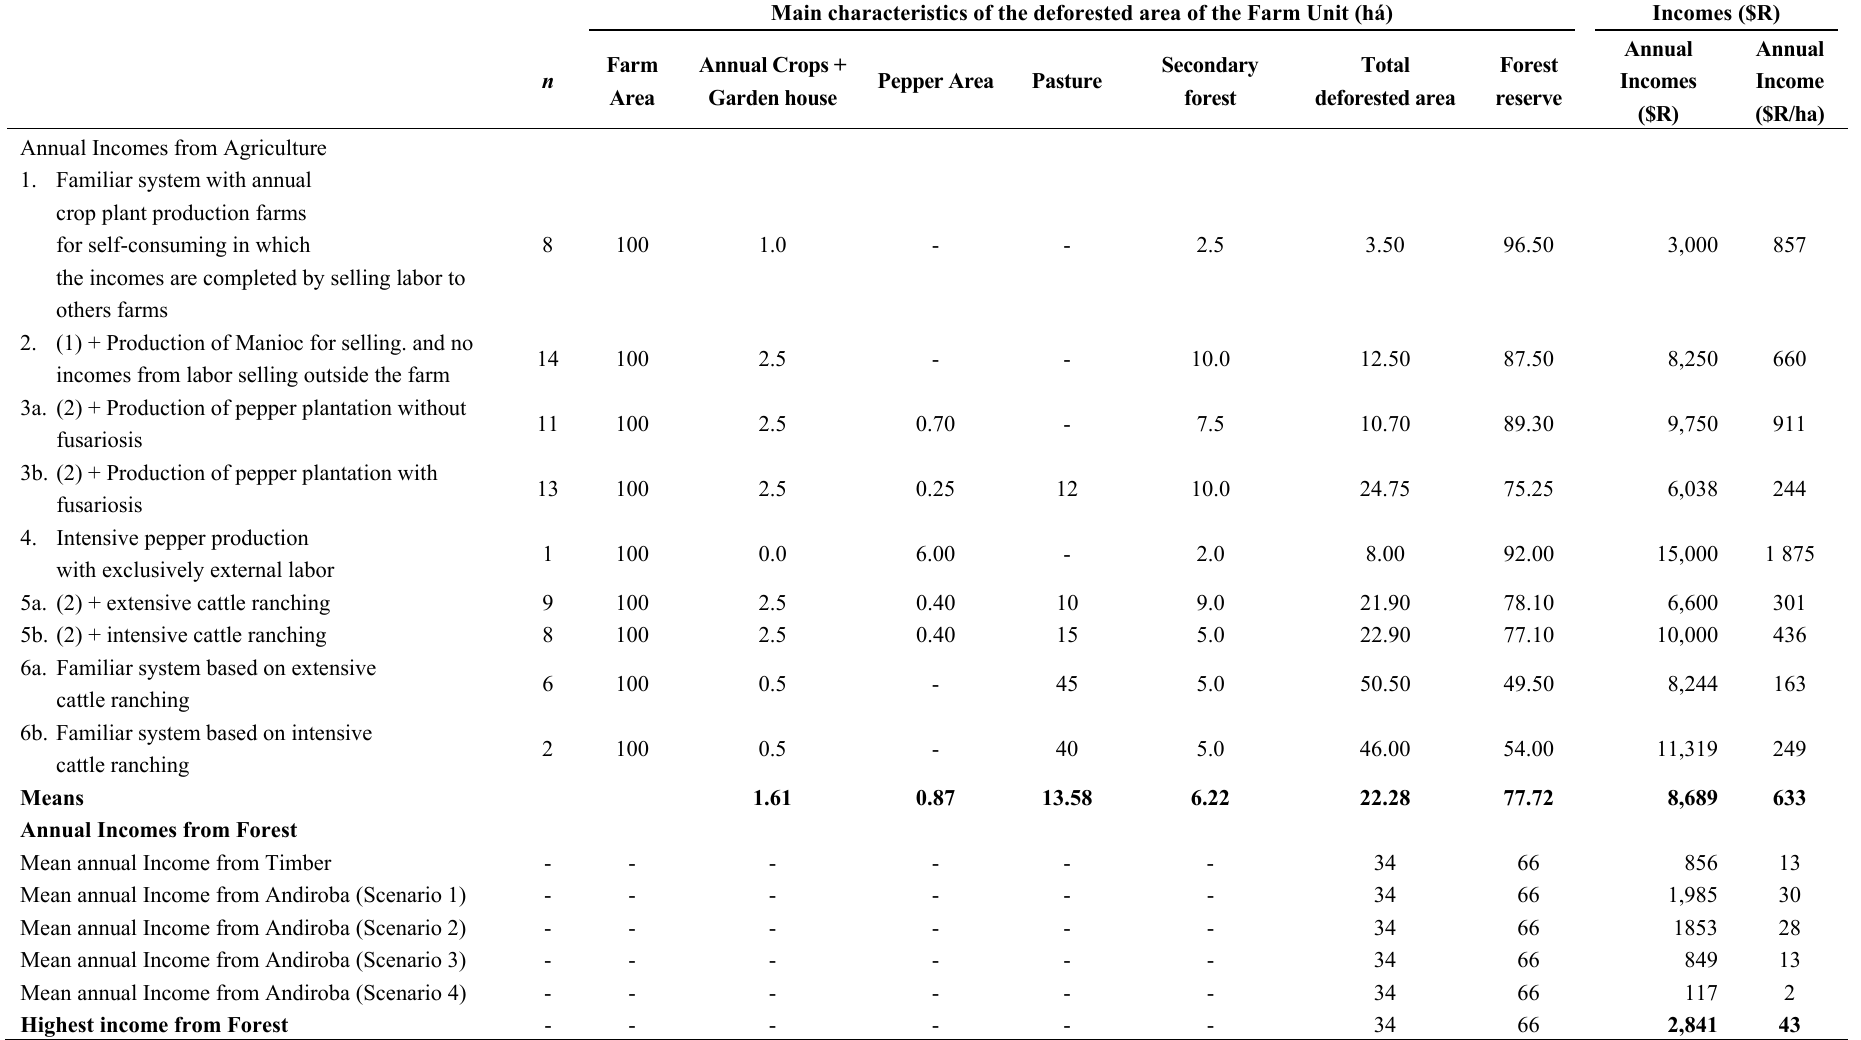
Table 6. Main types of agrarian production systems in the study area and mean annual incomes from agriculture and forest management. Main characteristics of the deforested area of the Farm Unit (há) Incomes ($R) Farm n Area Garden